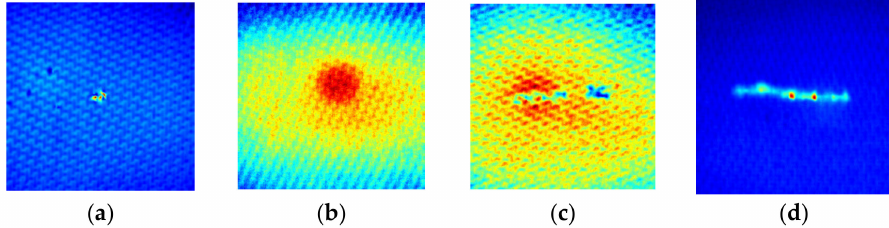
Figure 19. Thermographic images of the ( a ) front face and ( b ) back face of panel 6 and the ( c ) front face and ( d ) back face of panel